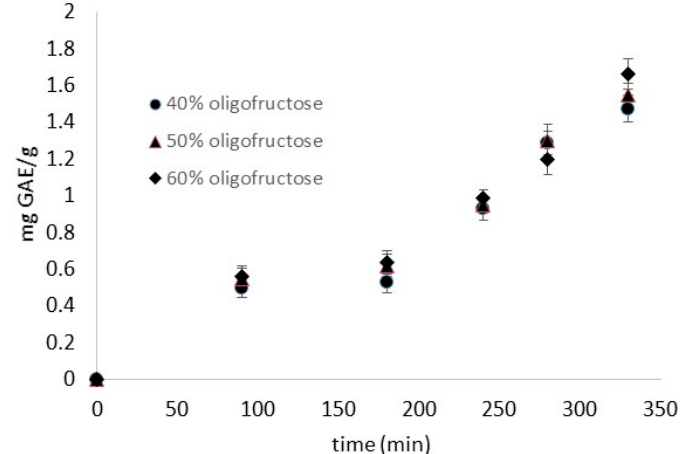
Figure 1. Impregnation of phenolics into fish tissue, expressed as mg gallic acid equivalents (GAE / g) (BP / OT procedure). Error bars represent the ± standard deviation of measurements. BP / OT: osmotic solutions consisting of oligofructose (40%–50%–60%) and 5% NaCl with former antioxidant enrichment by using Rosa damascena distillation by-products.